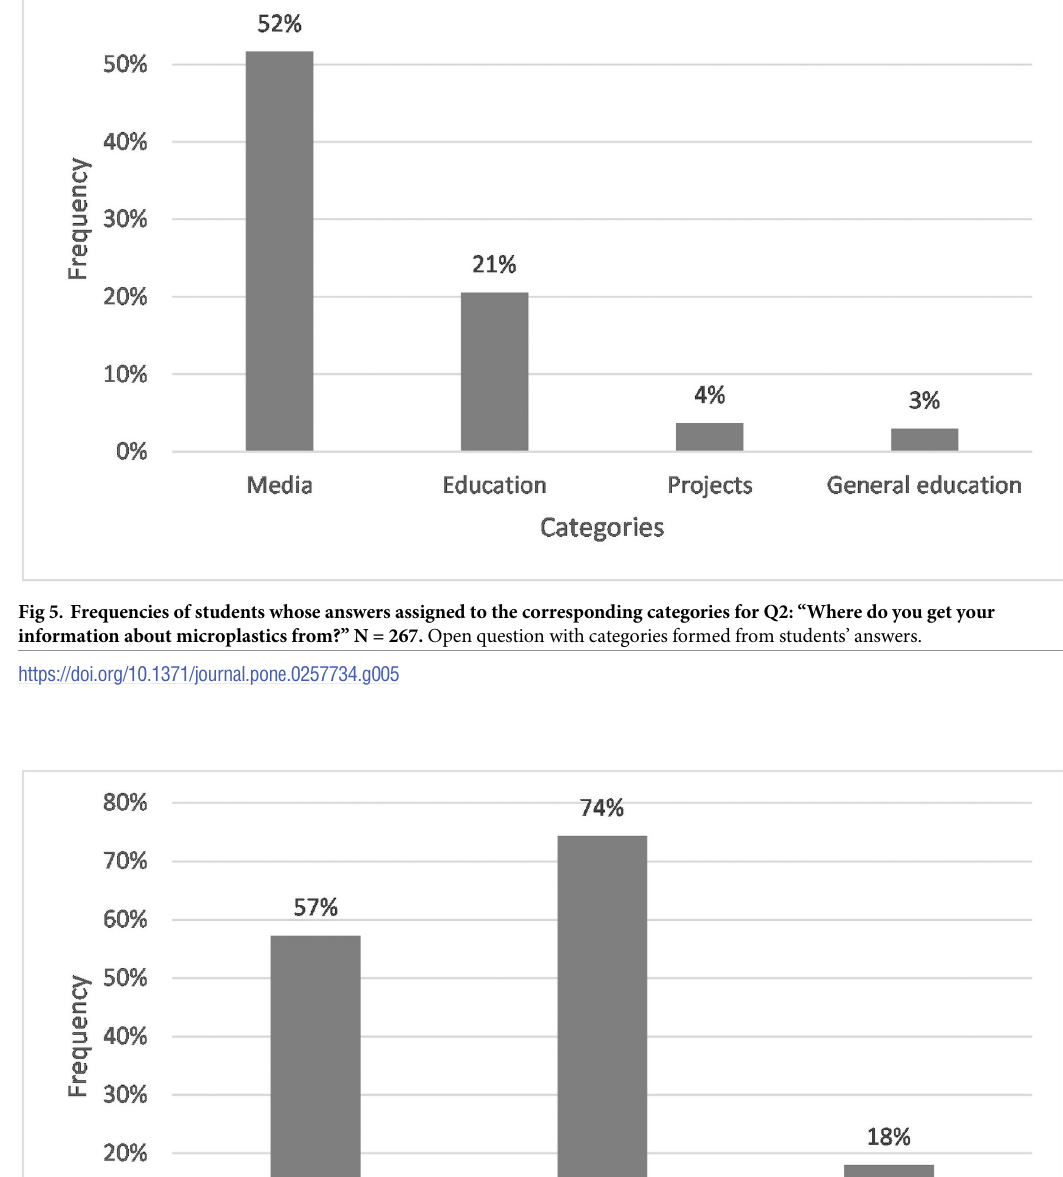
PLOS ONE | https://doi.org/10.1371/journal.pone.0257734 September 23,